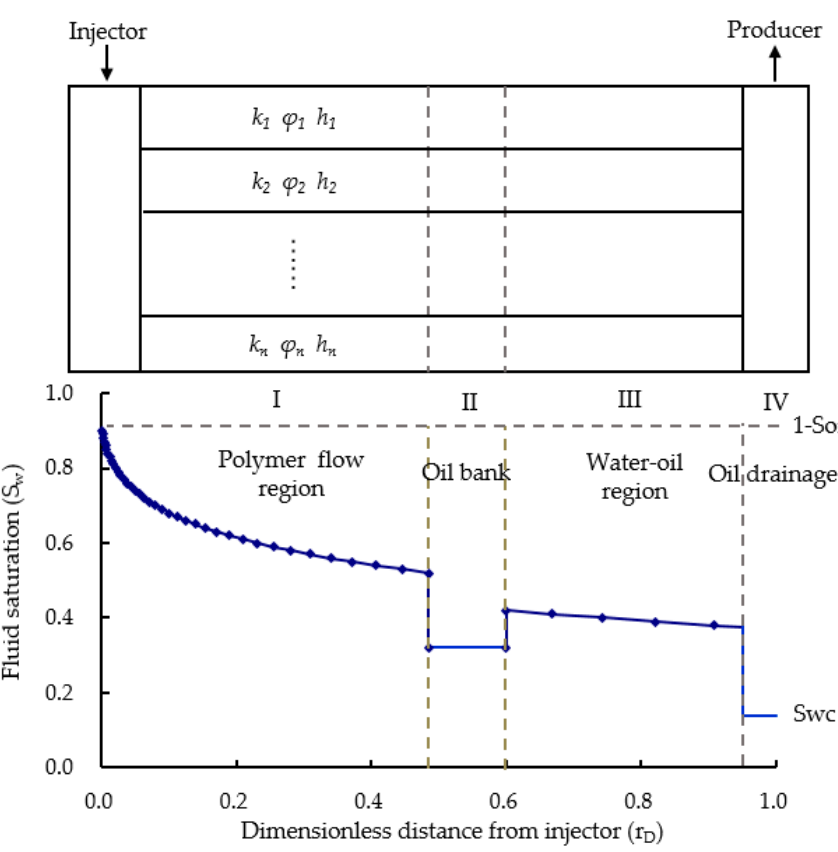
Figure 3. Fluid saturation distribution during polymer flooding.